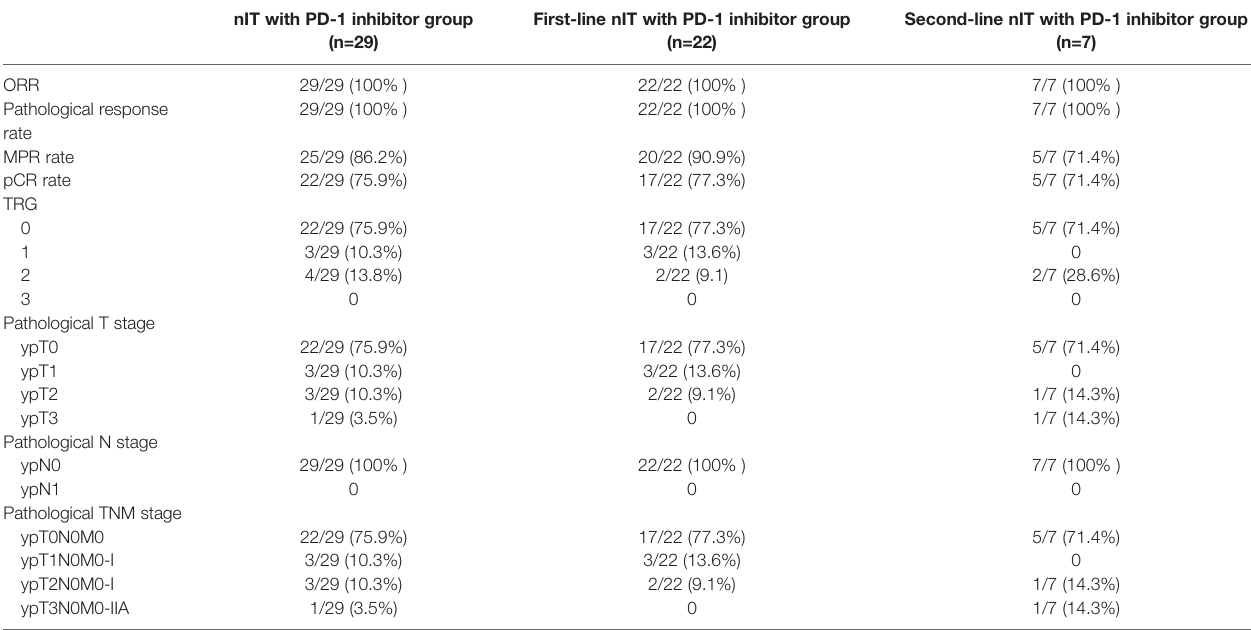
TABLE 2 | Pathological outcomes of dMMR/MSI-H LACRC patients treated with nIT and surgery. nIT with PD-1 inhibitor group First-line nIT with PD-1 inhibitor group Second-line nIT with PD-1 inhibitor group (n=29) (n=22)